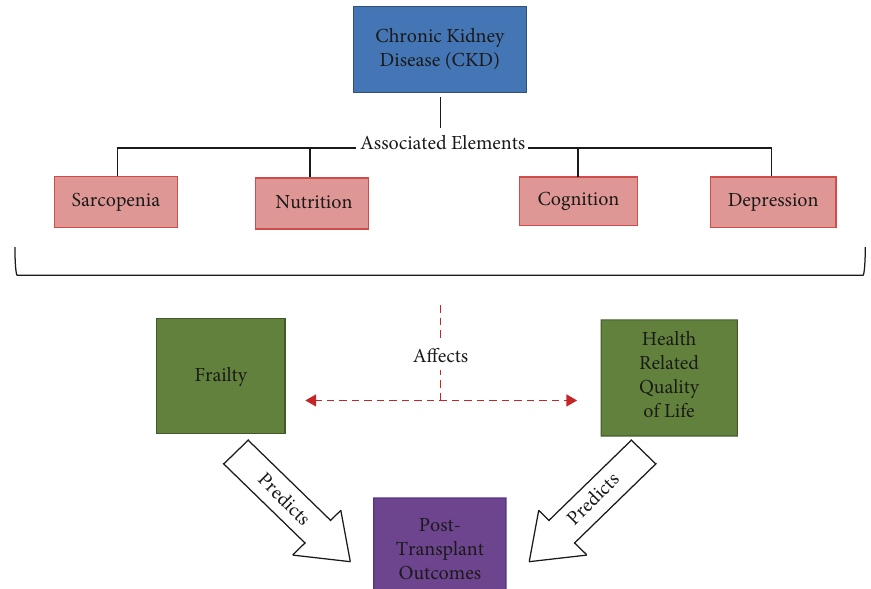
Figure 1: Chronic kidney disease (CKD) and its associated elements. Concept fgure demonstrating interrelation between aging-associated dysfunction, frailty, qualify of life, and posttransplant